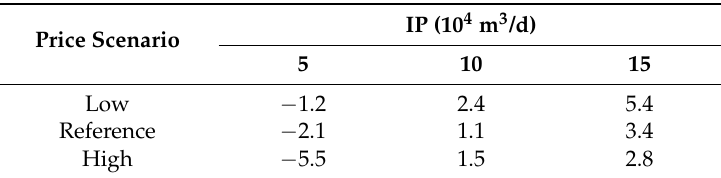
Table 4. NPV (10 8 yuan) for shale gas supply by M2.